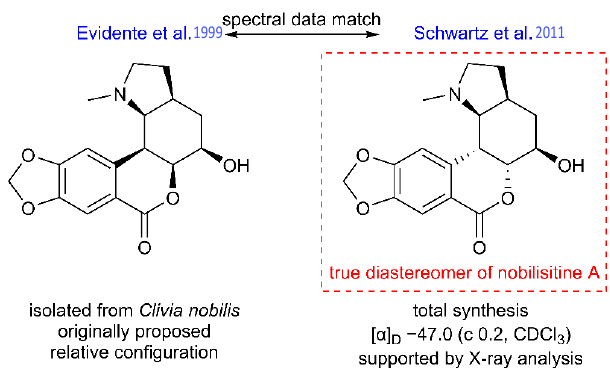
Figure 6. Nobilisitine A and its revised structure.